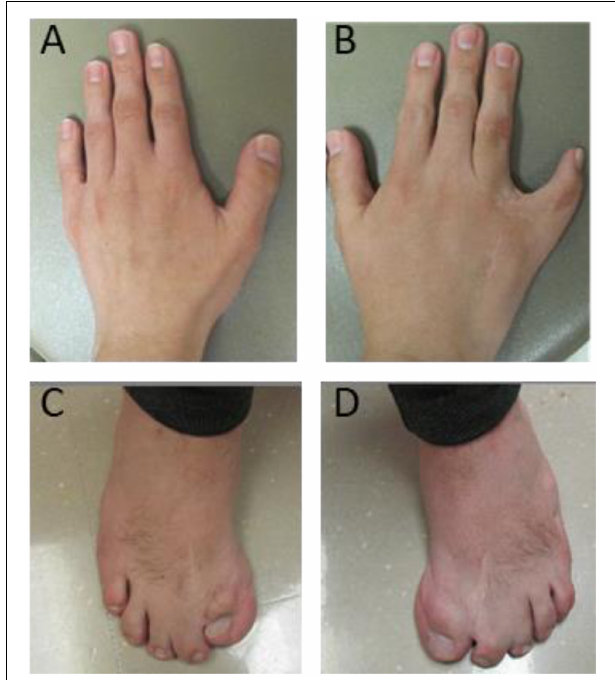
FIGURE 3 | Deformed hands and feet for case 33 with a proximal 1q21.1 duplication. The patient was born with severe syndactyly and polydactyly, including six fingers on left hand (A) , seven fingers on right hand (B) , seven toes on left foot (C) , and six toes on right foot (D) . Extra fingers and toes were surgically removed. However, syndactyly is still visible on his right hand (B) and feet (C,D) .